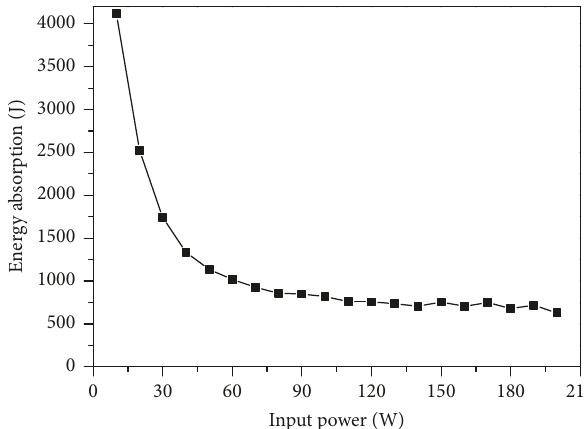
Figure 7: Temperature uniformity of different input power.